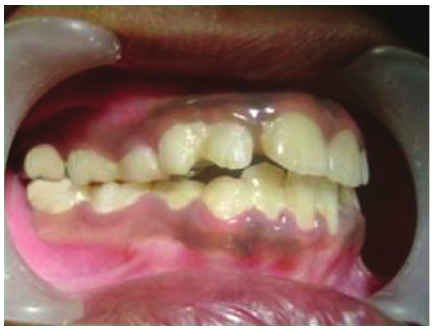
Figure 5: Lateral intraoral view following correction of anterior crossbite and posterior crossbite on the right